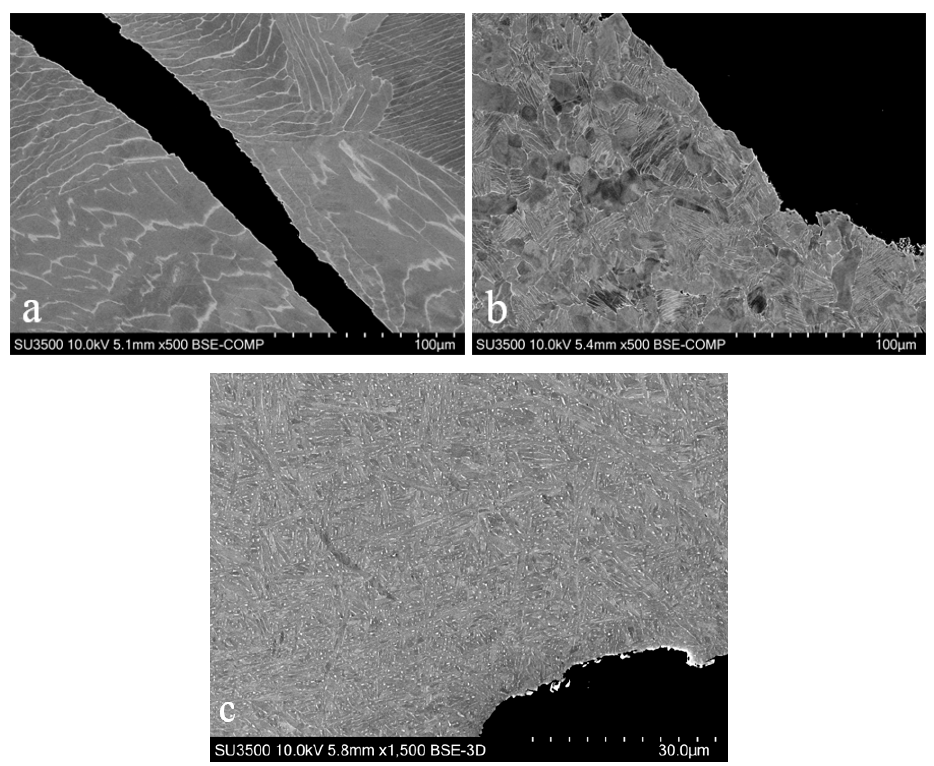
Figure 16. SEM images of the microstructural crack path through ( a ) cast and HIP ( b ) forged and ( c ) EBM disc specimens.